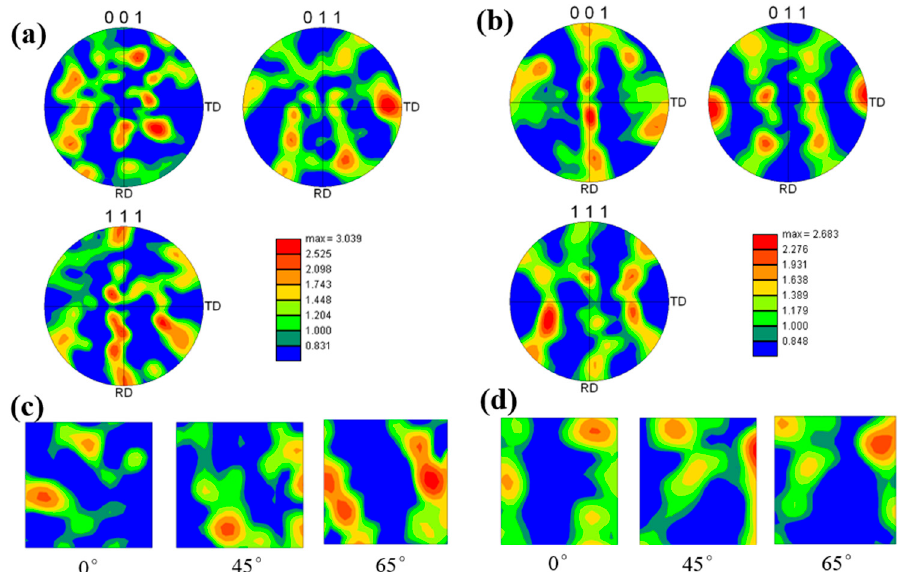
Figure 11. Pole figure and ODF maps of the new type of Cu-1.1–Ni-0.7–Co-0.45–Si-0.3Cr alloy in different deformation states: ( a , c ) 600 °C and 0.01 s − 1 , ( b , d ) 800 °C and 0.01 s − 1 .